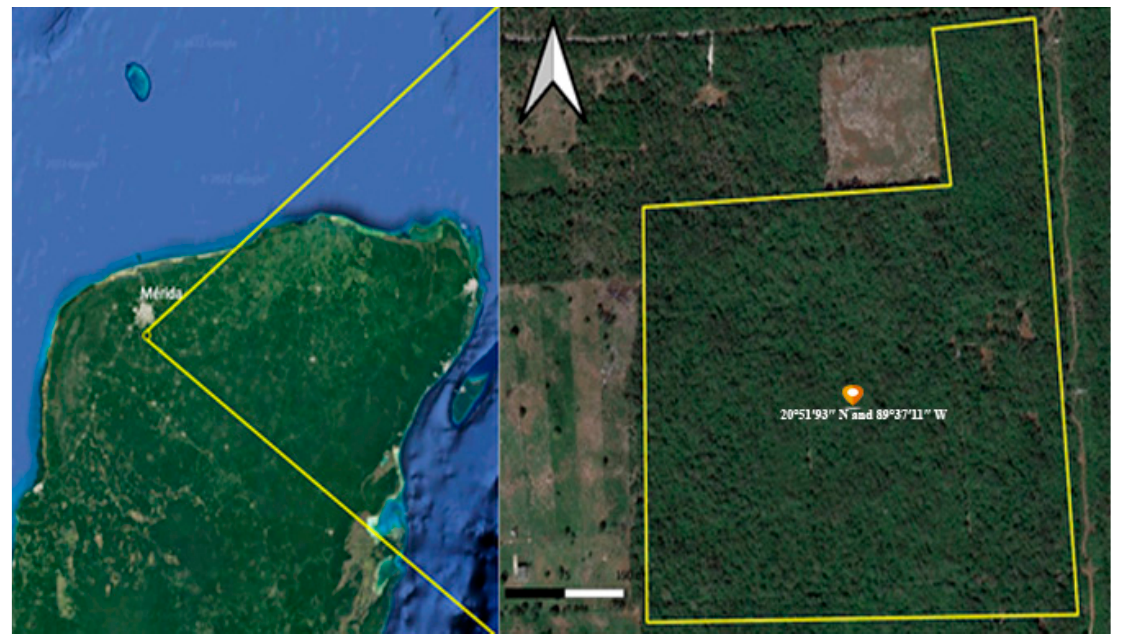
Figure 1. Map of the Yucatán Peninsula, México, showing the study area where the Gymnopodium floribundum trees are located (20°51 ′ 93 ″ N and 89°37 ′ 11 ″ W).